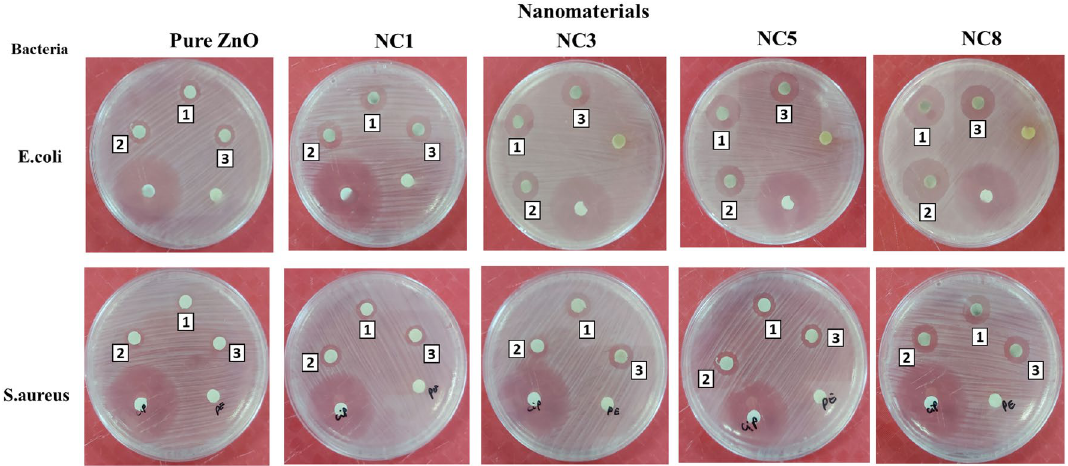
Figure 9. Real images showing the antibacterial activity of biosynthesized pure ZnO and Ag–ZnO nanocomposites with different Ag content (1%, 3%, 5%, and 8% Ag) against Escherichia coli and Staphylococcus aureus